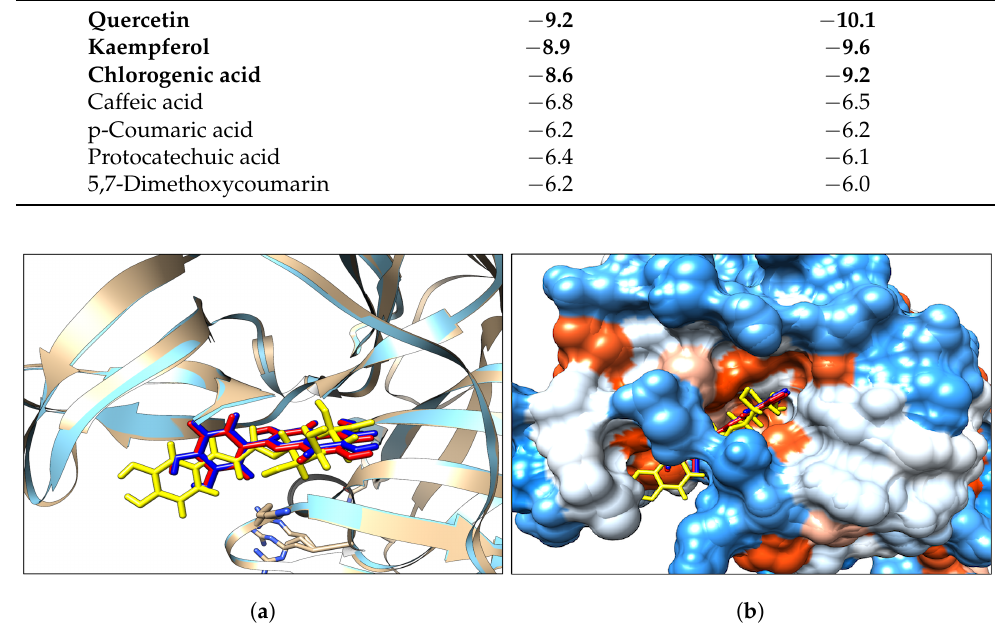
Figure 3. ( a ) NS3 protein Ribbon, ( b ) NS3 hydrophobicity surface with colors ranging from dodger blue for the most hydrophilic, white for neutral (i.e., 0.0 value), to orange red for the most hydrophobic. (Blue–Quercetin, red–Kaempferol, and yellow–Chlorogenic acid).